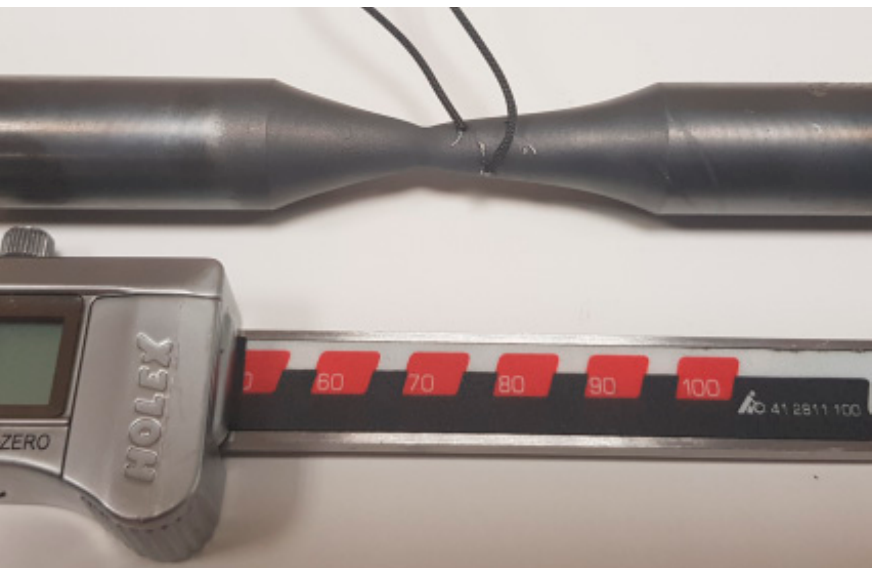
Figure 18. The view of the 20MnB4 steel sample after the deformation process in a complex deformation state (simultaneous torsion and tension) and location of the deformation outside the test area.